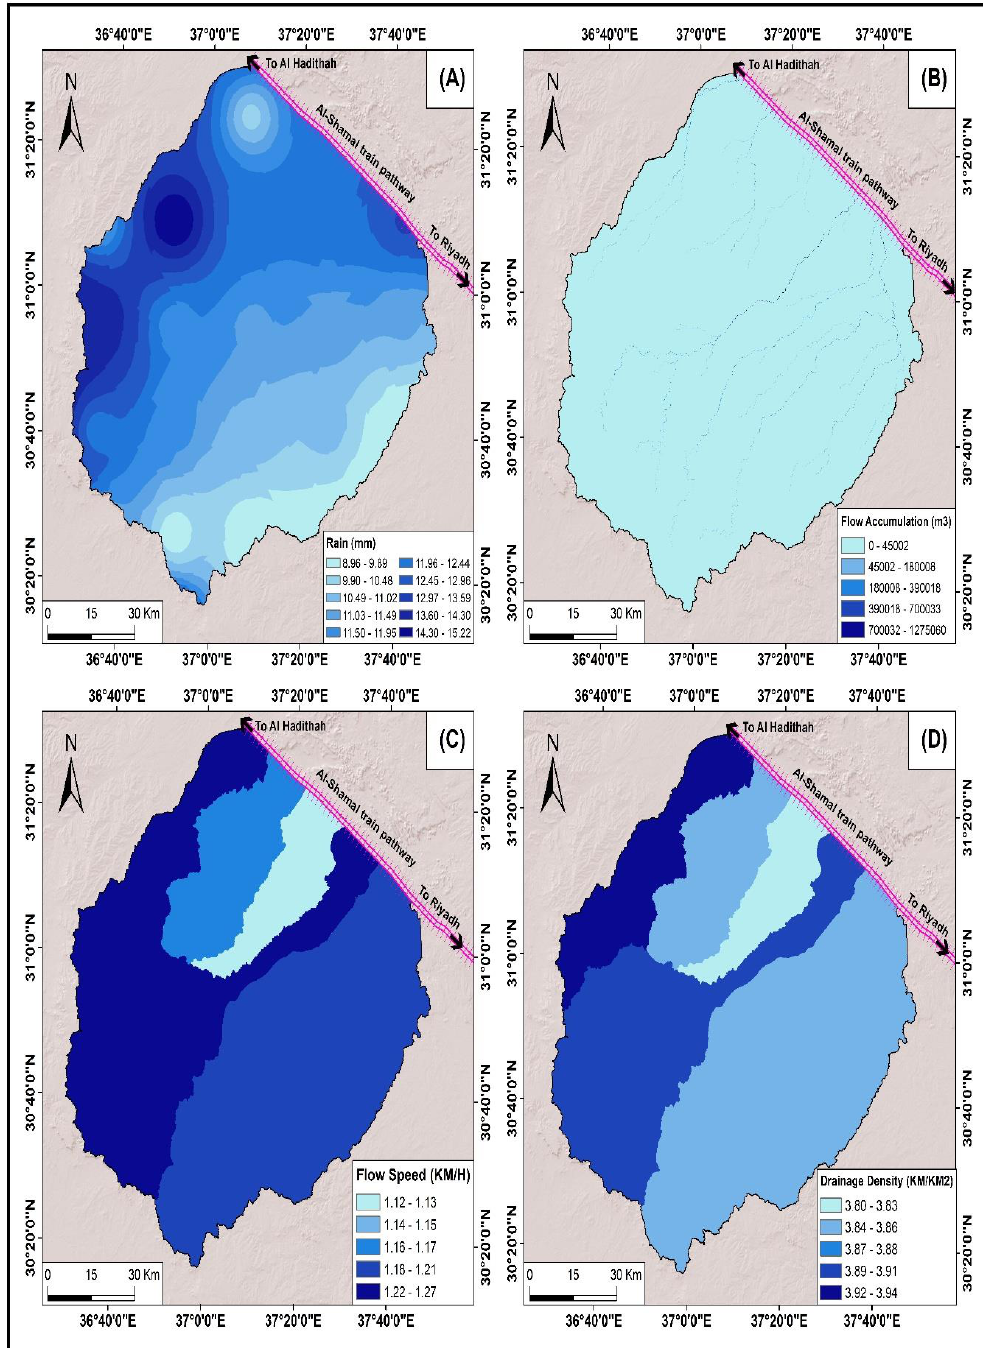
Figure 6. Criteria affecting the Al-Shamal train pathway to flood hazard in Al-Qurayyat city: ( A ) rainfall density; ( B ) flow accumulation; ( C ) runoff speed; and ( D ) drainage density. density; ( B ) flow accumulation; ( C ) runo ff speed; and ( D ) drainage